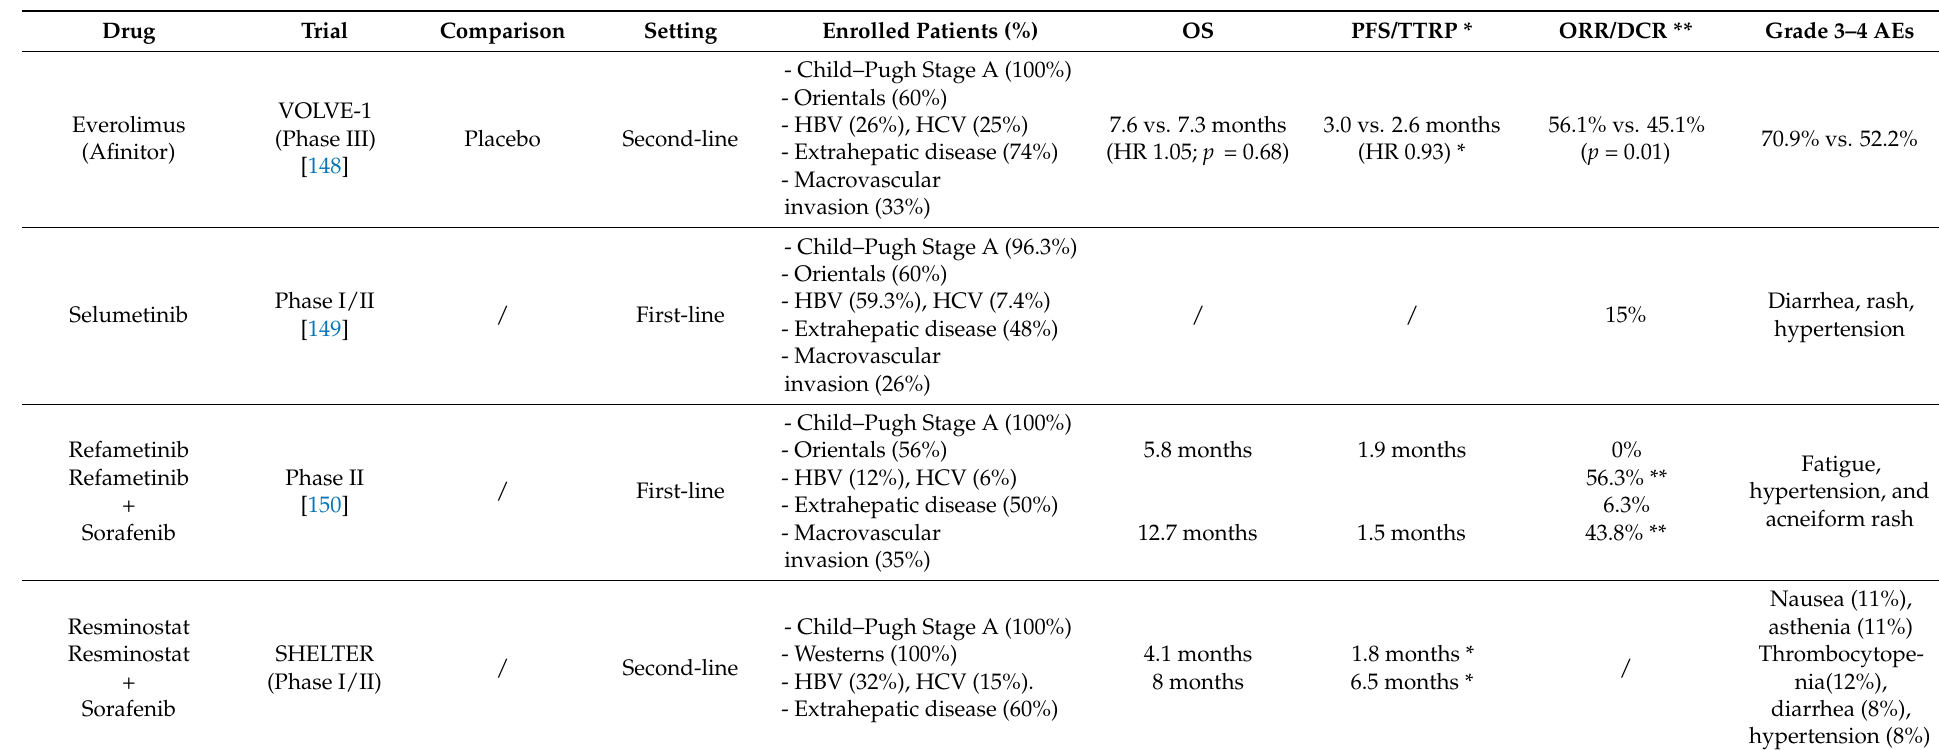
Table 5. Agents targeting the intracellular